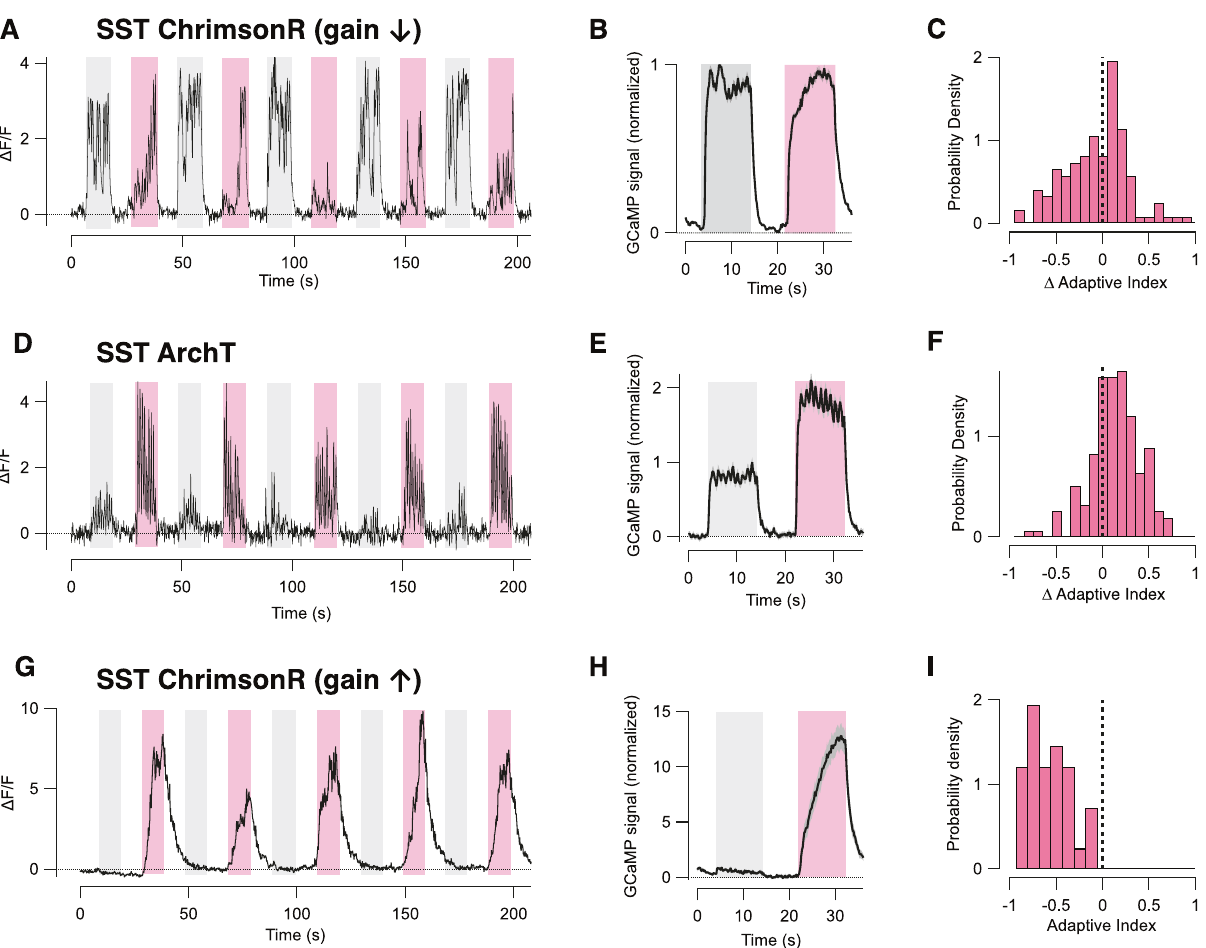
Fig. 5 SST interneurons drive sensitization of pyramidal cells. A An example of the response of a PC when optogenetically activating SST interneurons expressing ChrimsonR. Stimulus trials with LED illumination (pink bars) and without (grey bars) were interleaved. Increasing activity of SST cells decreased the initial gain, which was followed by sensitization. B Average of paired stimulus trials from experiments shown in A ( n = 3 mice, 552 cells). C The distribution of changes in adaptive index of PCs during SST cell activation. The shift towards negative values of AI (sensitization) was signi fi cant at p = 10 − 5 (WSR test). D An example of the response of a PC when optogenetically inhibiting SST interneurons expressing ArchT (pink bars). E Average of paired stimulus trials from experiments shown in D ( n = 3 mice, 319 cells). F The distribution of changes in AI of PCs during SST cell inhibition. The shift towards positive values of AI (depression) was signi fi cant at p = 0.02 (WSR test). G An example of responses from one of the subset of PCs (12% of total) that was not normally signi fi cantly responsive to the stimulus, but became strongly responsive on overactivating SST interneurons expressing ChrimsonR. H Average of paired stimulus trials from experiments illustrated by G ( n = 3 mice, 67 cells). In these PCs sensitization was correlated with a dramatic increase in gain, indicating that SST cells were exerting a disinhibitory effect. I The distribution of AI in PCs that became responsive during SST excitation through ChrimsonR: these were uniformly sensitizing (average AI = − 0.64 ± 0.22). Data are represented as mean ± SEM (grey shading area in B , E , H ) or probability density ( C , F , I ). Source data are provided as a Source Data fi